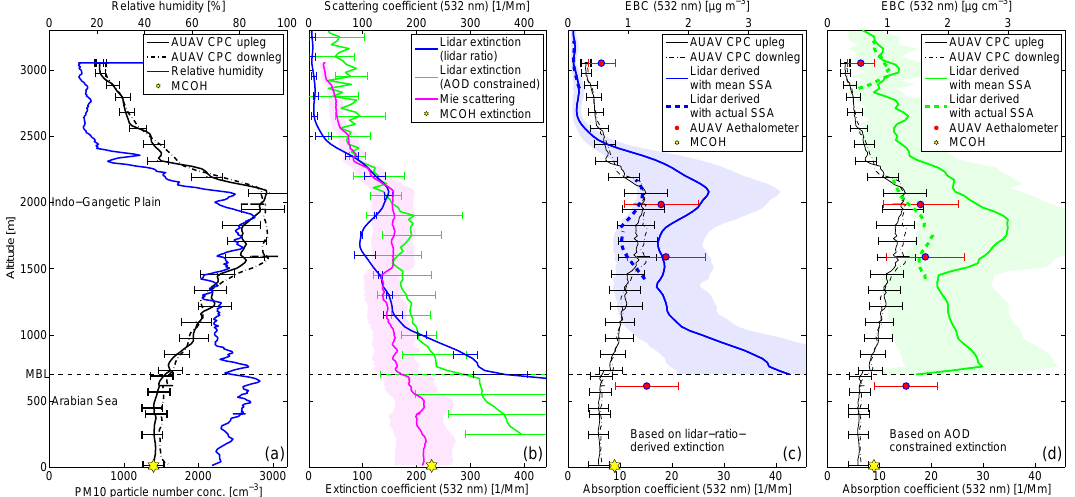
Figure 6. 24 March 2012. (a) Profile of PM 10 particle number concentration measured by AUAV CPC for upleg (black solid) and downleg (black dashed) flights and vertical relative humidity profile (blue). (b) Profile of particle extinction coefficient measured with the miniMPL (blue), scattering coefficient calculated with Mie theory (magenta). (c) Profile of particle absorption coefficient and EBC measured by an onboard aethalometer (red dots), estimated from lidar measurements (blue) with mean SSA and 50% uncertainty (blue shading), estimated from lidar measurements with actual SSA (blue dashed) and AUAV CPC approach (black). (d) Same as (c) but with lidar extinction coefficient constrained by AERONET AOD (green and green